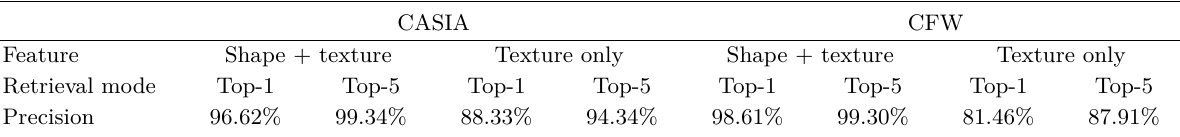
Table 3 Face retrieval results for different kinds of features